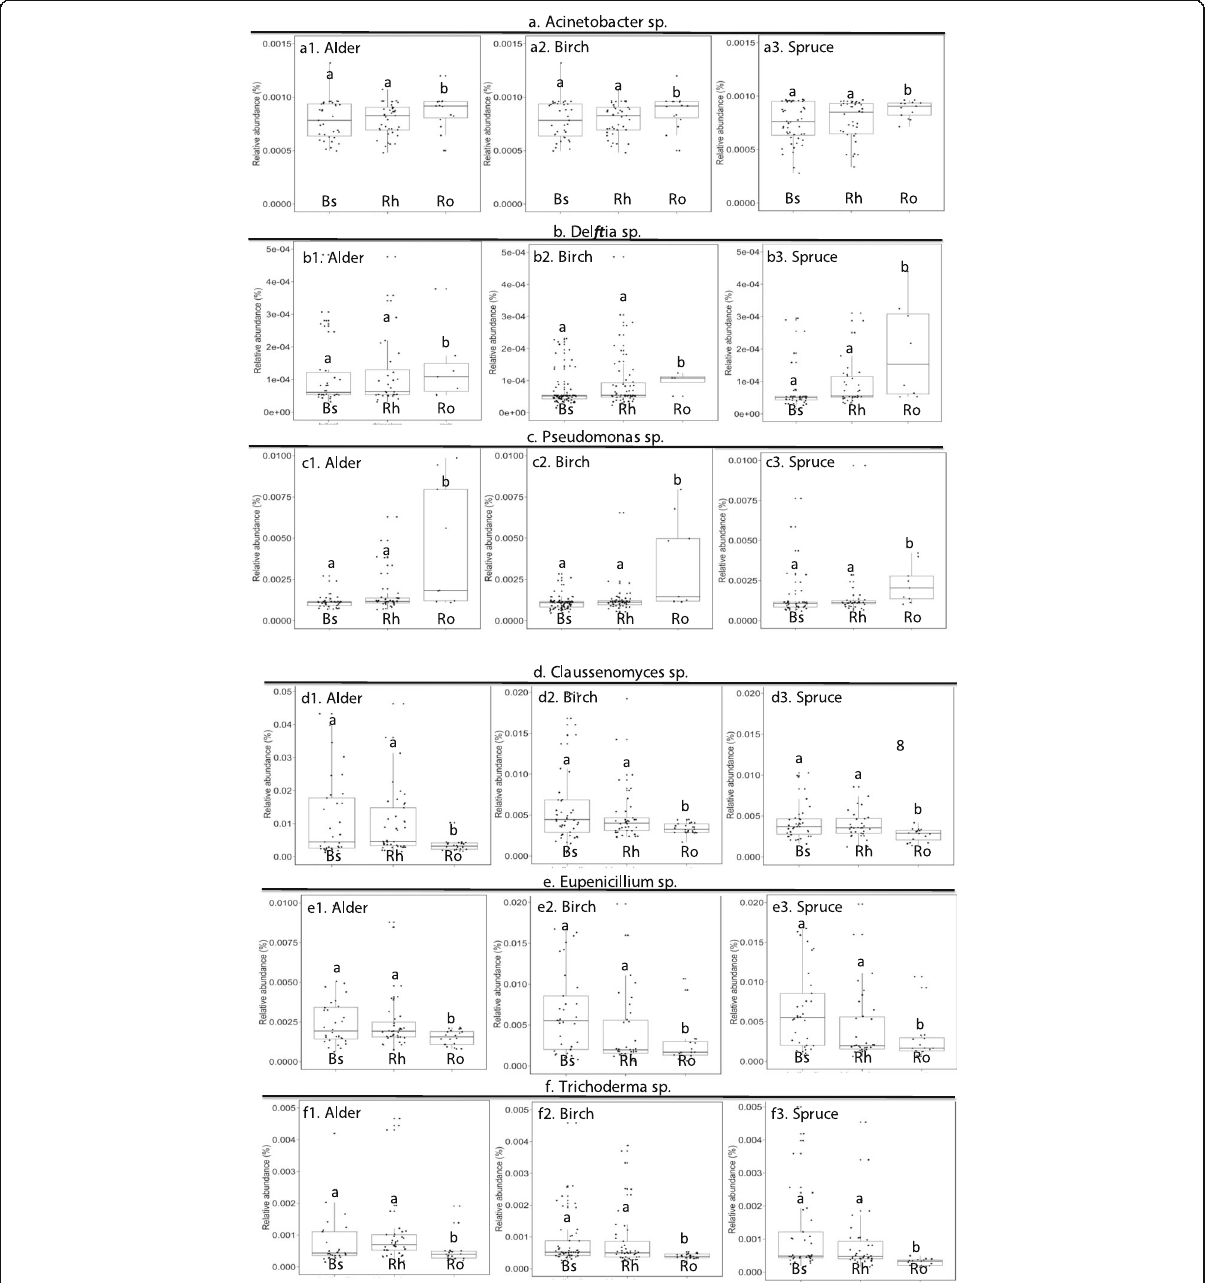
Fig. 7 Relative abundances (%) of various bacterial ( a – c ) and fungal species ( d – f ) in bulk soil (Bs), the rhizosphere (Rh), and roots (Ro) of alder, birch, and spruce. Different letters represent a significant difference after unbalanced ANOVA followed by Tukey ’ s multiple comparison test. Non- parametric Kruskal-Walis test followed by Dunn multicomparison test was done when data transformation was not possible to meet the normality